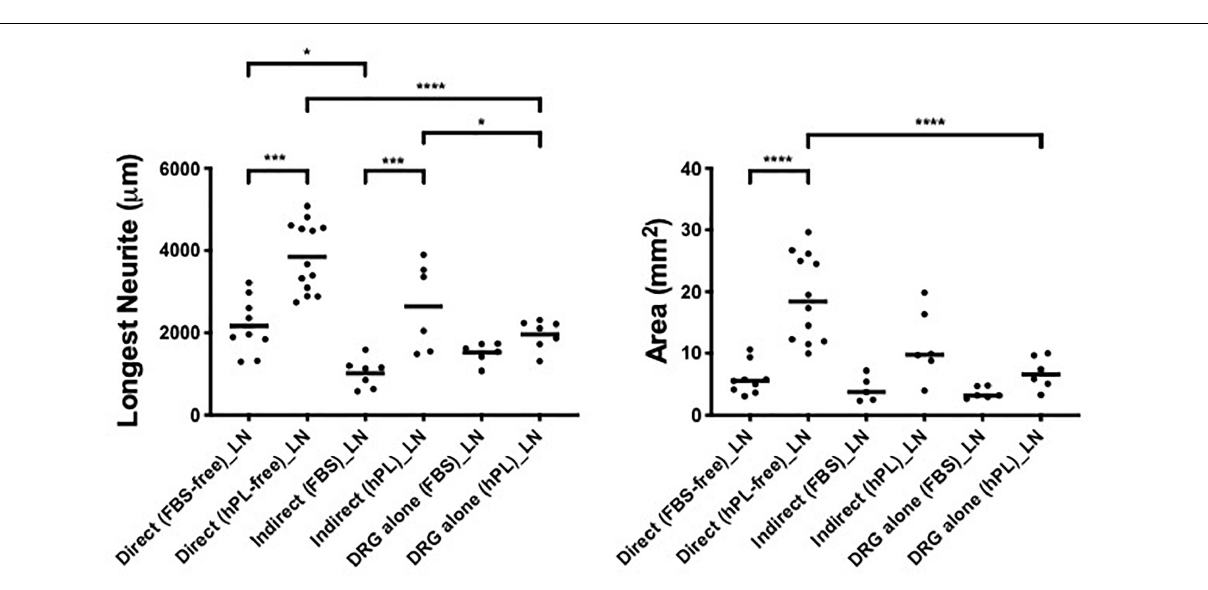
FIGURE 5 | Influence of laminin on DRG outgrowth. Longest neurite and axonal area of direct co-culture, indirect co-culture, and DRG alone on laminin (LN). Three biological repeats and at least three technical replicates (DRG) were assessed. One-way ANOVA with Tukey’s multiple comparison tests was used for assessing statistical significance among the examined groups (* p < 0.05, ** p < 0.01, *** p < 0.001, **** p < 0.0001). The number of DRG tested corresponds to the number of dots for each condition in the